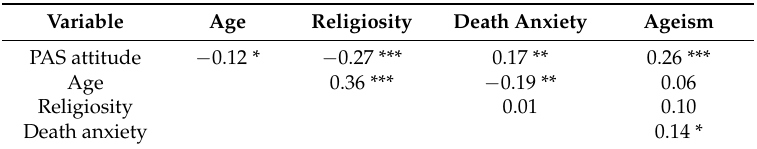
Table 2. Zero-order correlations between attitude toward PAS, age, religiosity, death anxiety and ageism (N = 216).